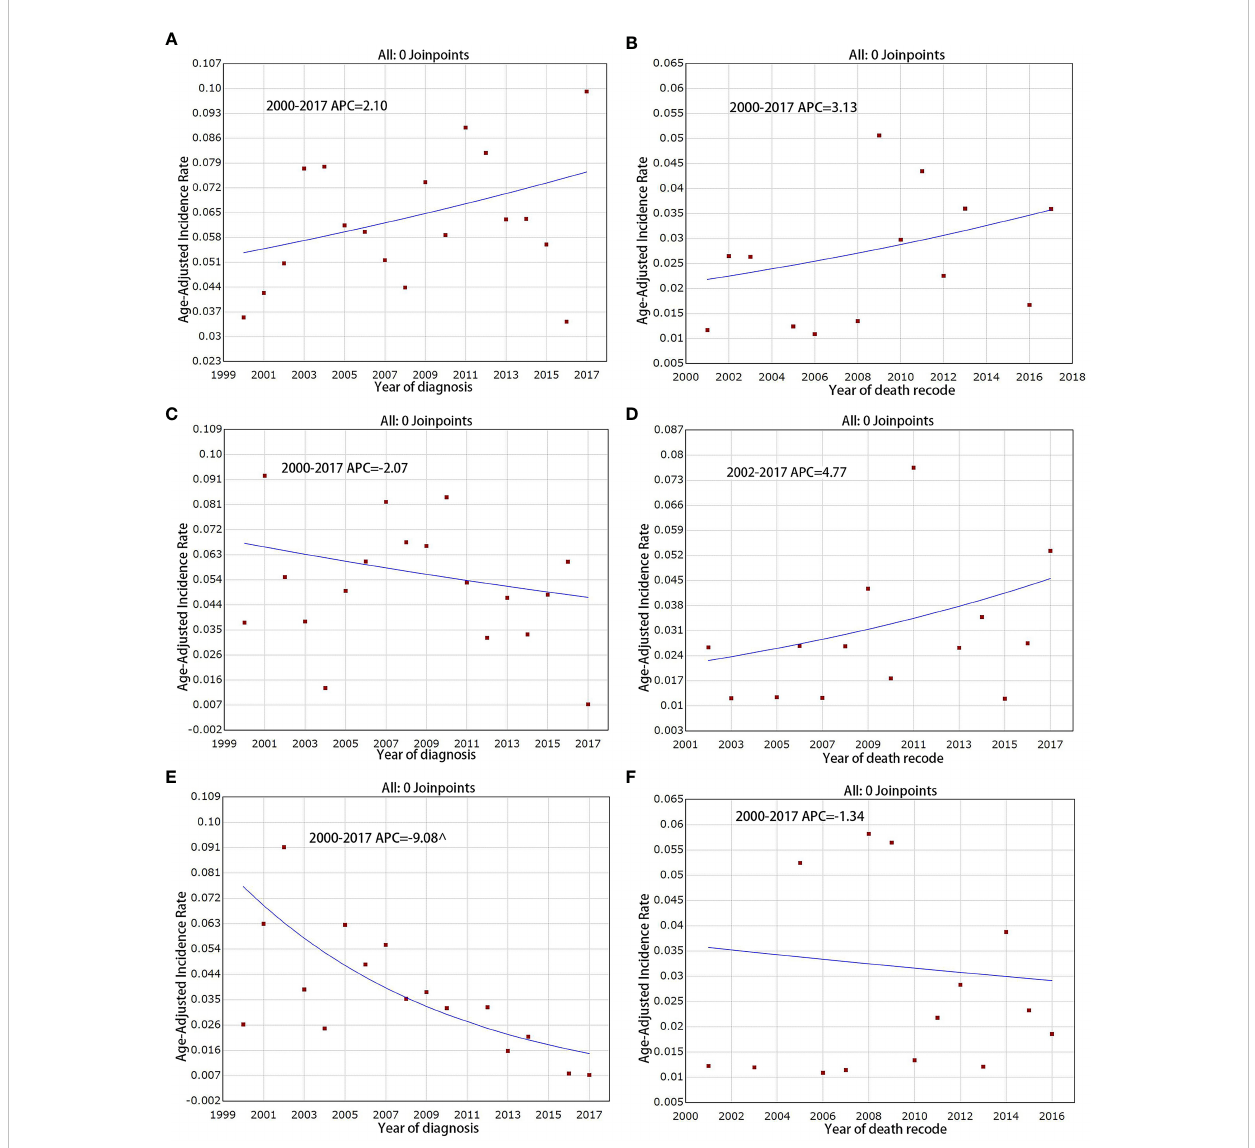
FIGURE 4 Incidence and IB mortality trends in Insulinoma, Gastrinoma and RF-PNETs overall 2000 – 2017. (A) Incidence trends in Insulinoma. (B) IB mortality trends in Insulinoma. (C) Incidence trends in Gastrinoma. (D) IB mortality trends in Gastrinoma. (E) Incidence trends in RF-PNETs. (F) IB mortality trends in RF-PNETs. ^ mean that P < 0.